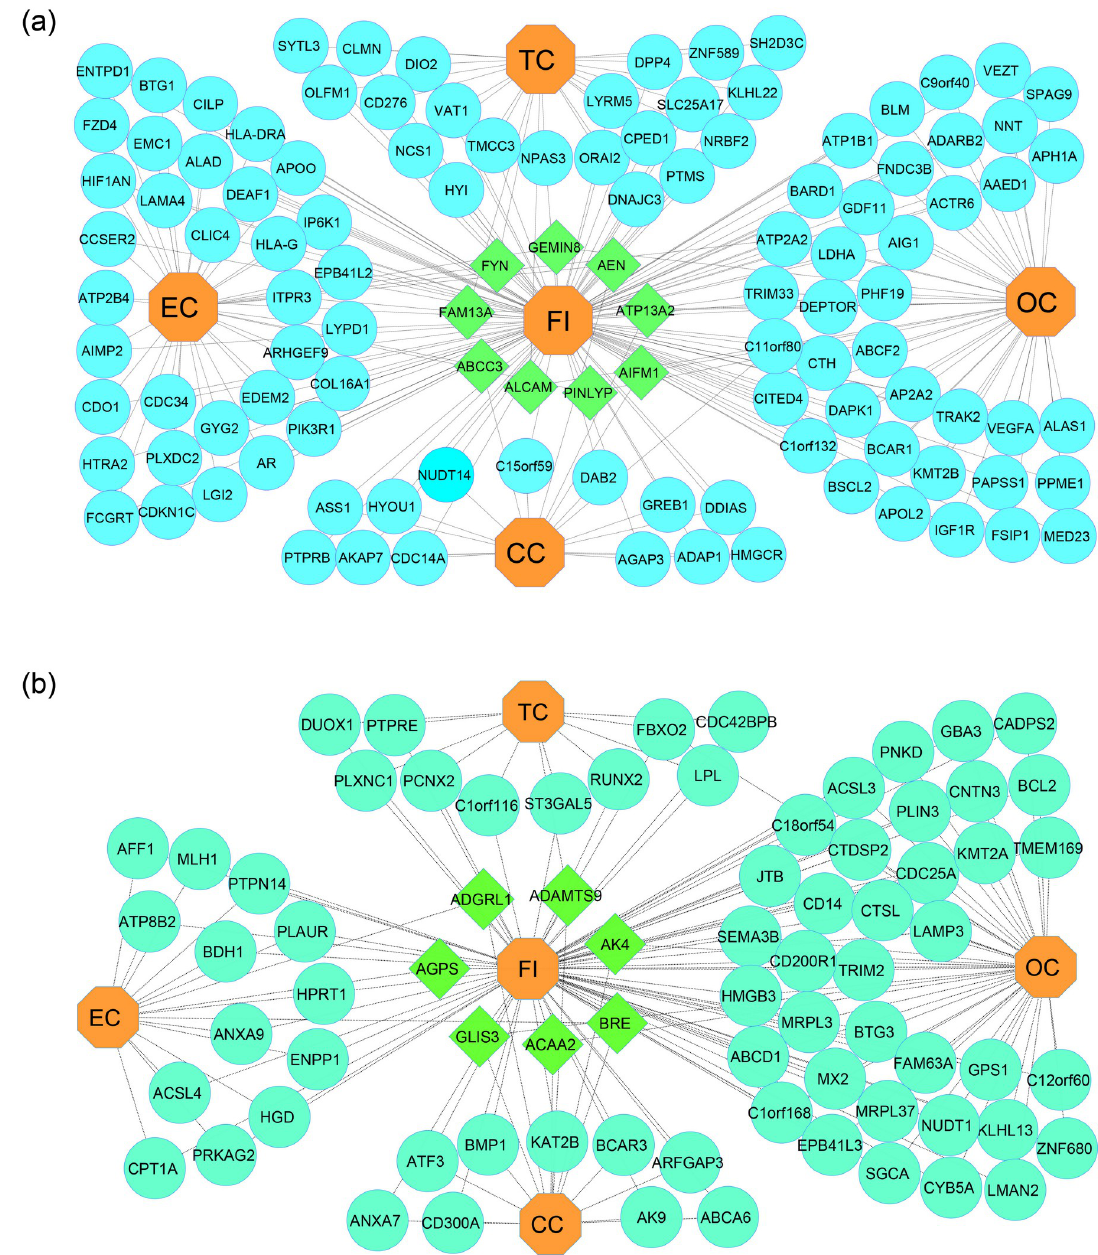
Fig 3. a : Gene-Disease network of common DEGs having upregulated genes between Female Infertility (FI) with Endometrial Cancer (EC), Ovarian Cancer (OC), Cervical Cancer (EC), and Thyroid Cancer (TC). Octagon-shaped and light red color nodes represent four risk factors, while round-shaped and sky color nodes represent DEGs. Square-shaped and green color nodes indicate DEGs are common among FI and four risk factors. b : Gene-Disease network of common DEGs having down-regulated genes between Female Infertility (FI) with Endometrial Cancer (EC), Ovarian Cancer (OC), Cervical Cancer (EC) and Thyroid Cancer (TC). Octagon-shaped and light red color nodes represent four risk factors, while round-shaped and sky color nodes represent DEGs. Square-shaped and green color nodes indicate DEGs are common among FI and four risk